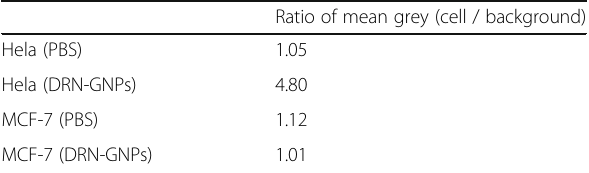
Table 2 Comparison of DRN-GNPs taken up by Hela and MCF-7 cells. The ratio of the value of the cells ’ densitometric mean (grey) to that of the background in the same image Ratio of mean grey (cell /